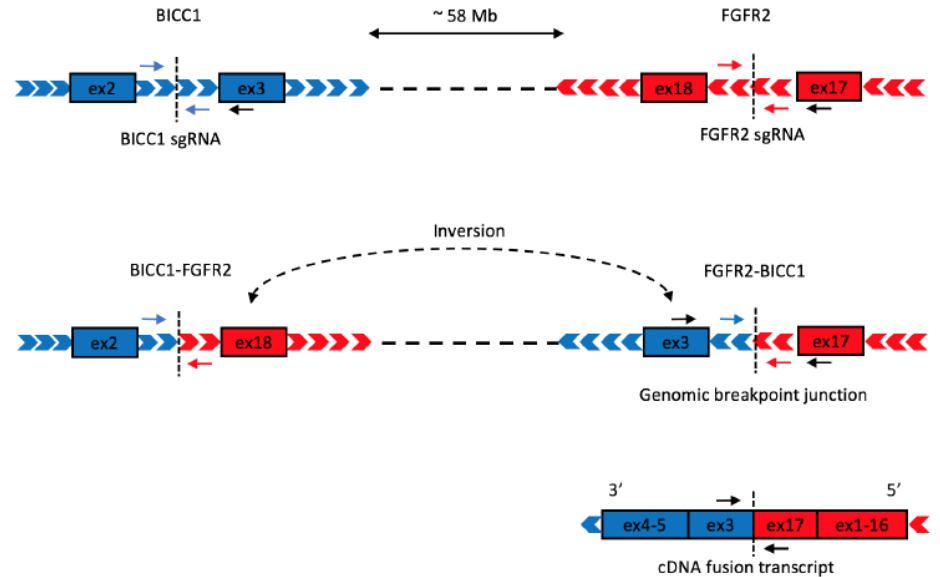
Figure 1. Schematic of clustered regularly interspaced short palindromic repeats (CRISPR)-induced inversion resulting in the fibroblast growth factor receptor 2 (FGFR2)–Bicaudal family RNA binding protein 1 (BICC1) gene fusion. ( A ) sgRNAs target the intronic region of FGFR2 and BICC1 on chromosome 10 (dotted lines). Arrows: primers for detection of WT FGFR2 , WT BICC1 , and FGFR2–BICC1 . ( B ) The FGFR2–BICC1 gene fusion results from an inversion of a 58-megabase fragment. ( C ) The fusion transcript comprises FGFR2 exons 1-17 fused to BICC1 exons 3-5.